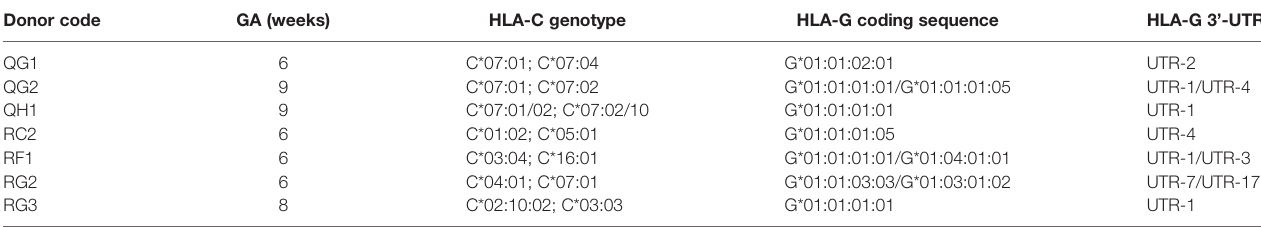
TABLE 3 | Overview of the trophoblast cultures characterized in the study and their HLA-C and HLA-G genotypes 1, 2